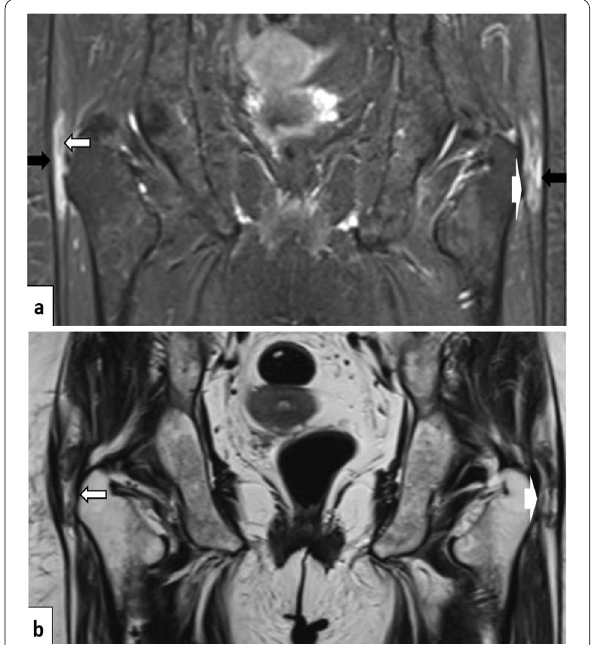
Fig. 1 a Coronal PDFS: bilateral trochanteric bursitis (black arrows). Ill-defined Gluteus medius tendon on the right side denoting full thickness tear (white arrow). Increased thickness of the Gluteus medius tendon on the left side showing interstitial edema (white arrowhead). b Coronal T2: confirms full thickness tear of the Gluteus medius on the right side (white arrow). On the left side, the Gluteus medius tendon is thinned denoting partial thickness tear (white arrowhead)